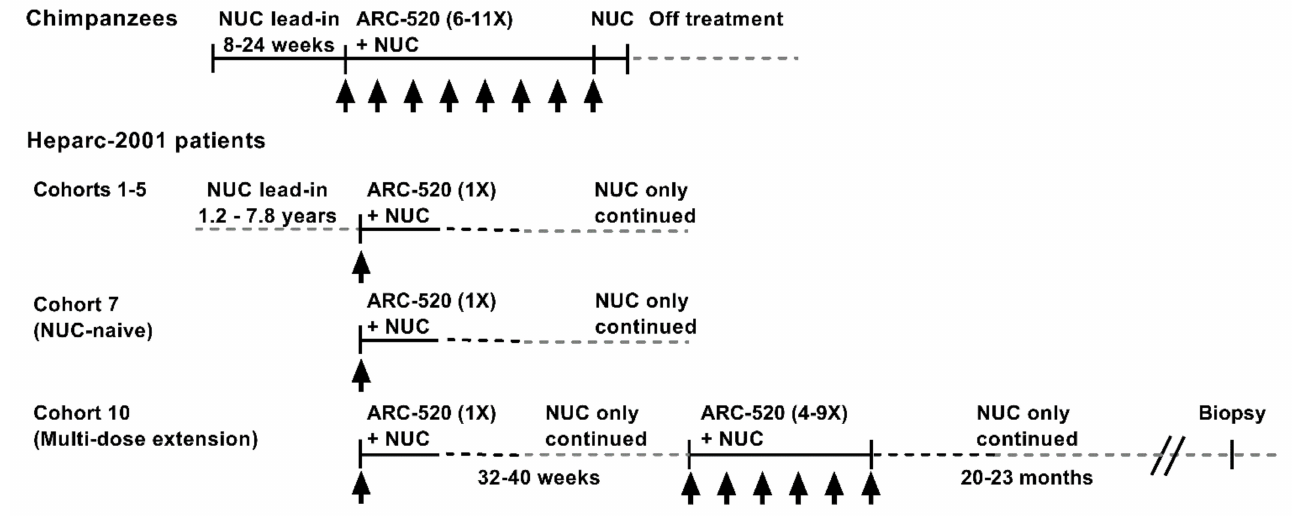
Figure 1. Schematic of ARC-520 study in chimpanzees and clinical trial Heparc-2001 in chronically HBV-infected patients treated with